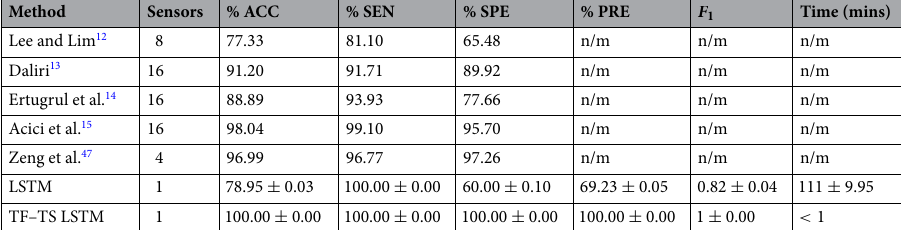
Table 2. Ten-fold cross-validation metrics for classification of gait of patients with Parkinson’s disease and healthy controls. LSTM = direct use of time series by bi-LSTM, TF–TS LSTM = use of time–frequency and time–space features of time series by bi-LSTM, and n/m = not